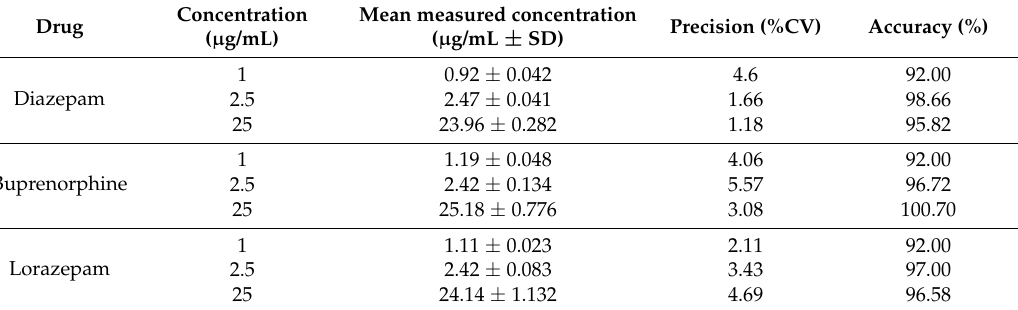
Table 2. Intra-day accuracy and precision of HPLC methods.